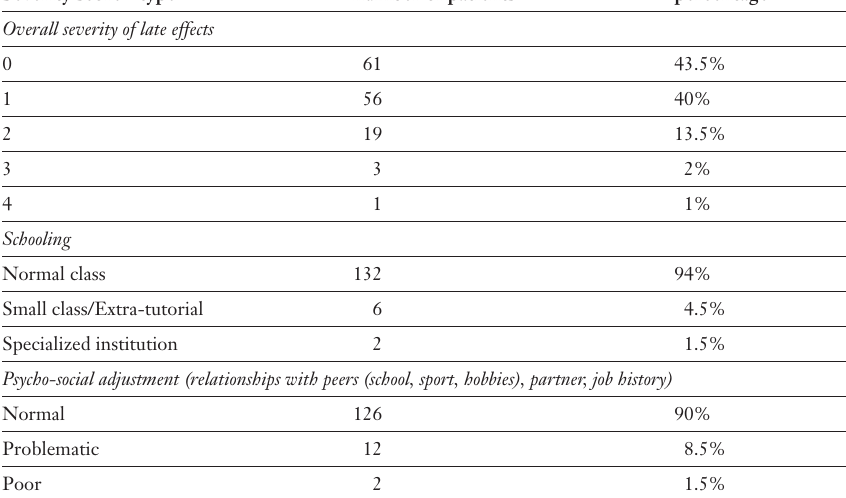
Global results (n = 140 patients